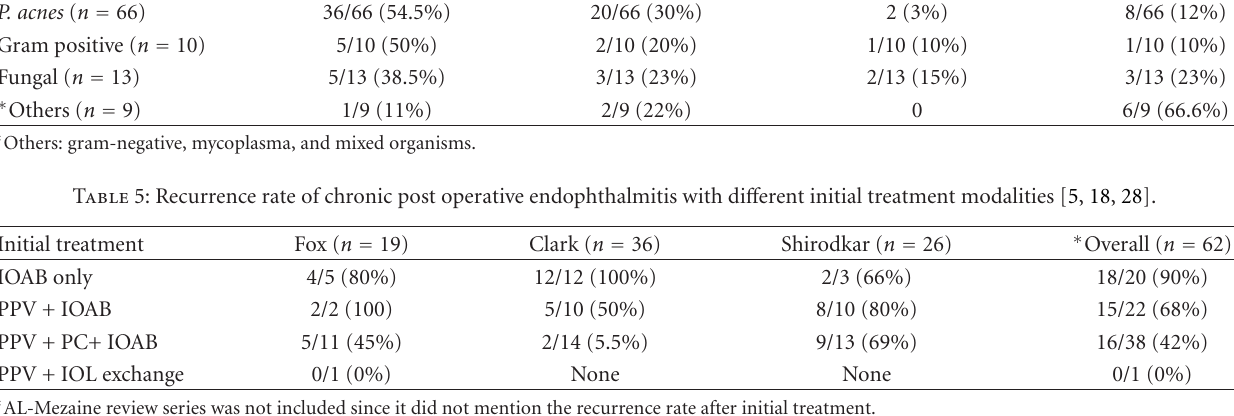
Table 4: Visual acuity outcomes by causative organism in chronic post operative endophthalmitis [5, 16, 18, 28]. Organism